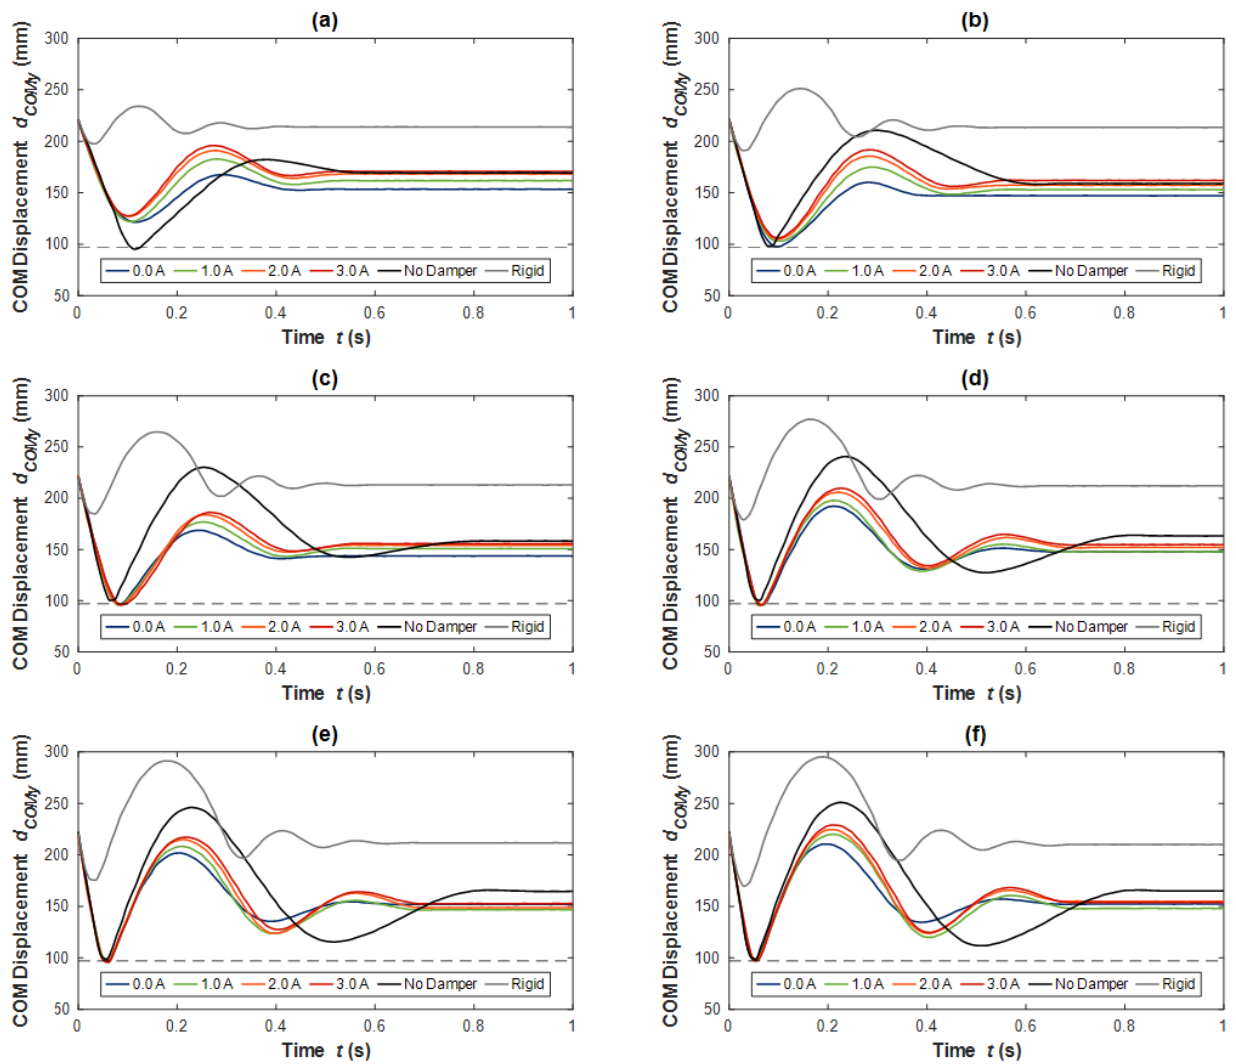
Figure 5. COM displacement for impact tests with a 4.60 kg total mass for drop heights of ( a ) 100 mm, ( b ) 200 mm, ( c ) 300 mm, ( d ) 400 mm, ( e ) 500 mm, and ( f ) 600 mm.